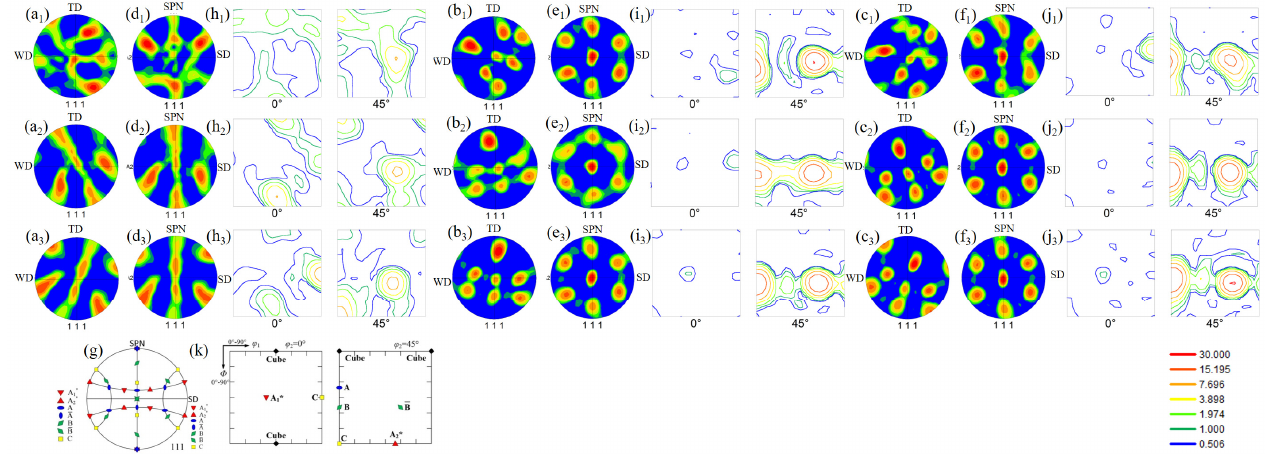
Figure 8. Original (111) pole figures at x = –3.0, 0.0, and 2.0 for pure Al at ( a 1 – a 3 ) 0.56 T m and ( b 1 – b 3 ) 0.67 T m ; ( c 1 – c 3 ) high-purity Al at 0.50 T m . ( d 1 – d 3 ), ( e 1 – e 3 ), and ( f 1 – f 3 ) rotated (111) pole figures and ( g ) standard pole figures. ( h 1 – h 3 ), ( i 1 – i 3 ), and ( j 1 – j 3 ) orientation distribution function (ODF) and ( k ) standard ODF maps at φ 2 = 0 º and 45 º, where the cube stands for the 45° rotated cube texture.